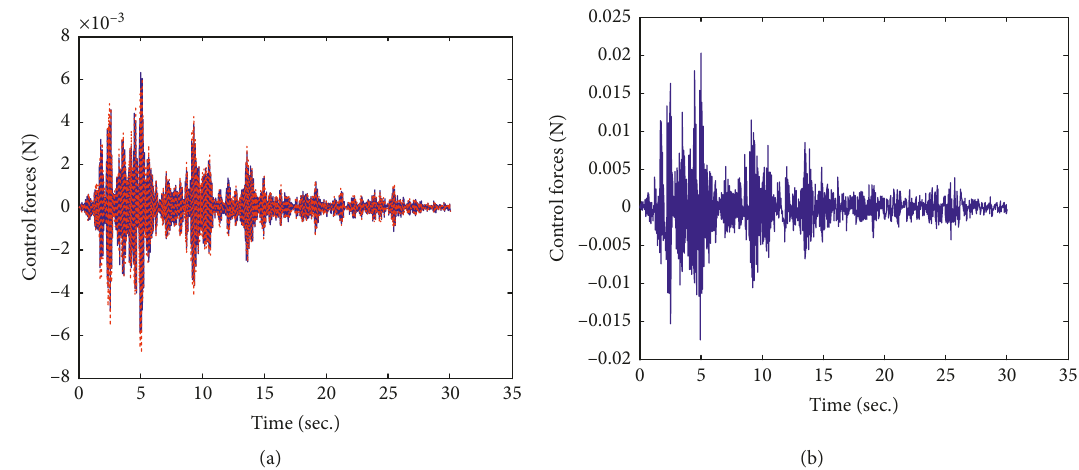
Figure 12: Comparison of control forces by the TMD and LTMD at node 10. (a) Constraint forces exhibited by the LTMD; (b) control forces exhibited by the TMD.